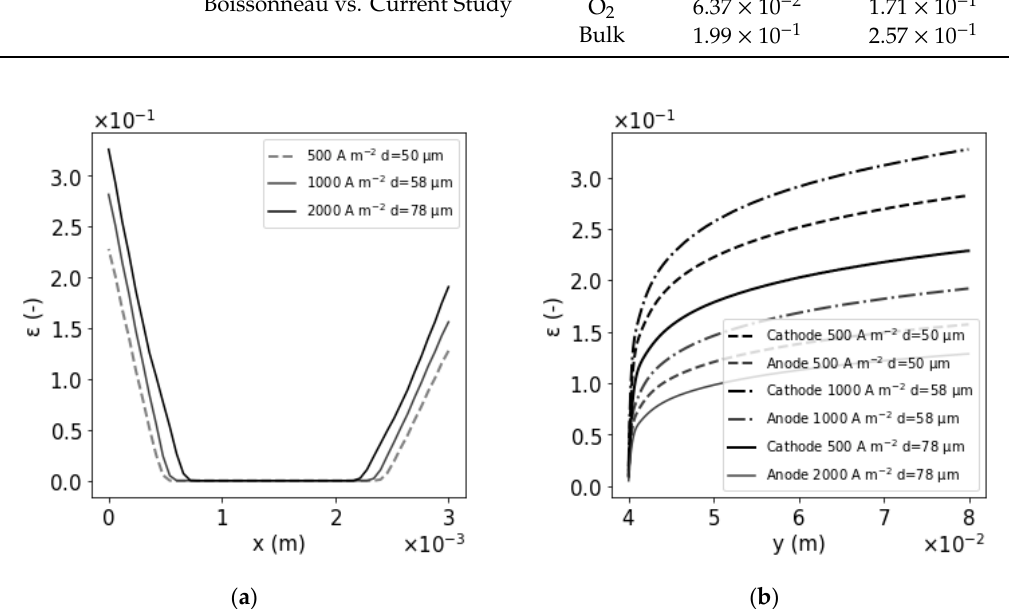
Figure 6. Void fraction evolution depending on the electrolyte width ( a ) and electrode height ( b ) for the three current density 500, 1000 and 2000 A m − 2